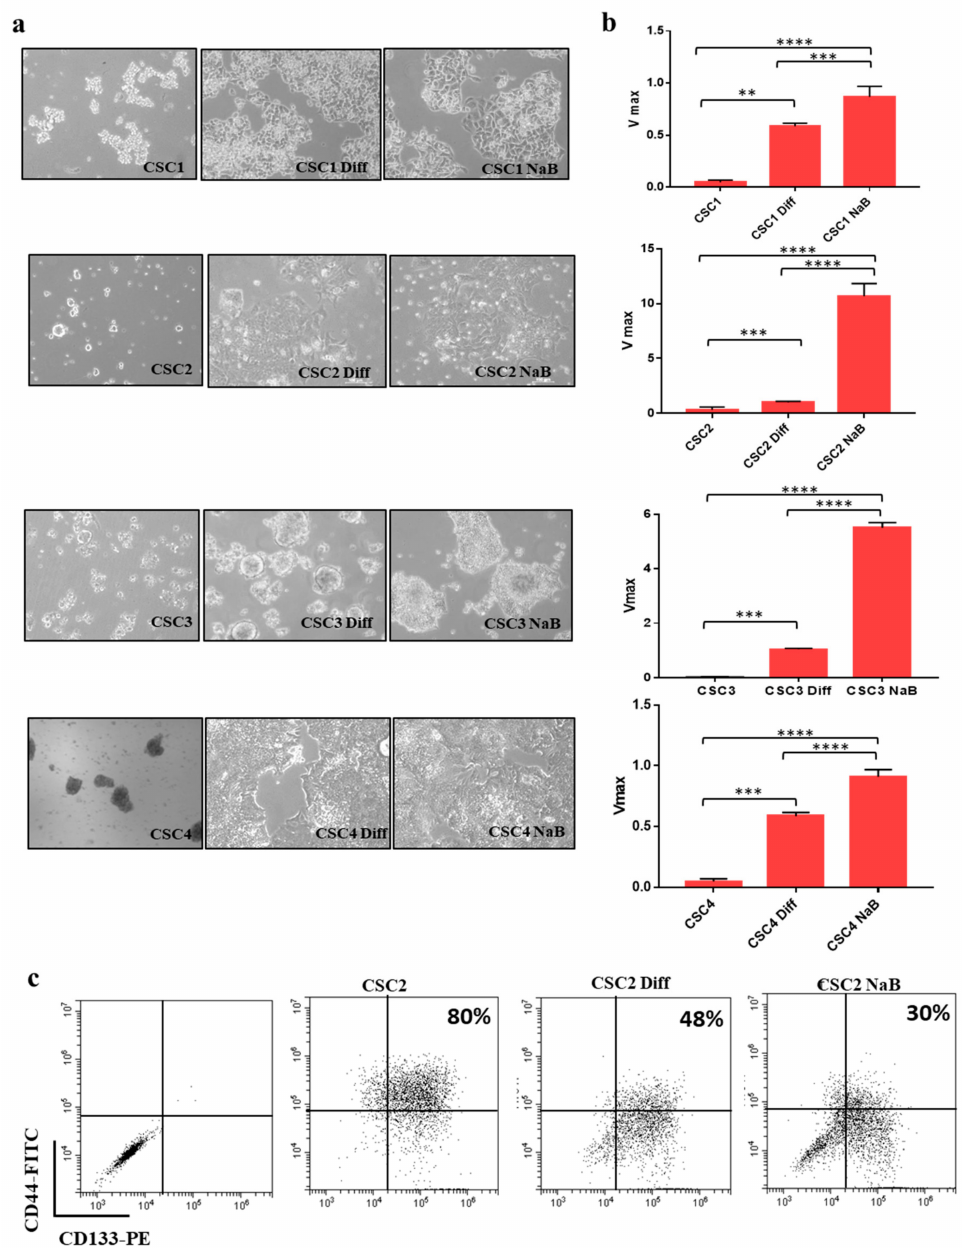
Figure 1. Colorectal cancer stem cell lines (CR-CSCs) can be induced to di ff erentiate. ( a ) CR-CSCs (Sa41, Re121, U11 and Sa47) undergoing di ff erentiation showed morphological changes, magnification = 100 × . ( b ) Phosphatase alkaline activity increased in CR-CSC grown in adhesion (Di ff ) and even more in CR-CSCs treated with NaB (2 mM) thus confirming di ff erentiation. The images of the di ff erentiating CR-CSCs are representative of the whole experiment. ( c ) CR-CSCs markers decreased in di ff erentiated cells. Expression of CD133 and CD44 was assessed by flow cytometry. The double positive cells (CD133 + / CD44 + ) decreased during the di ff erentiation process (from 80% to 30%). Di ff = CR-CSCs were grown with 10% FBS in the absence of growth factors (adhesion condition) for seven days; NaB = CR-CSCs were grown in adhesion condition for seven days and then treated with 2 mM NaB for 48 h. **, p ≤ 0.005; ***, p ≤ 0.001; ****, p ≤